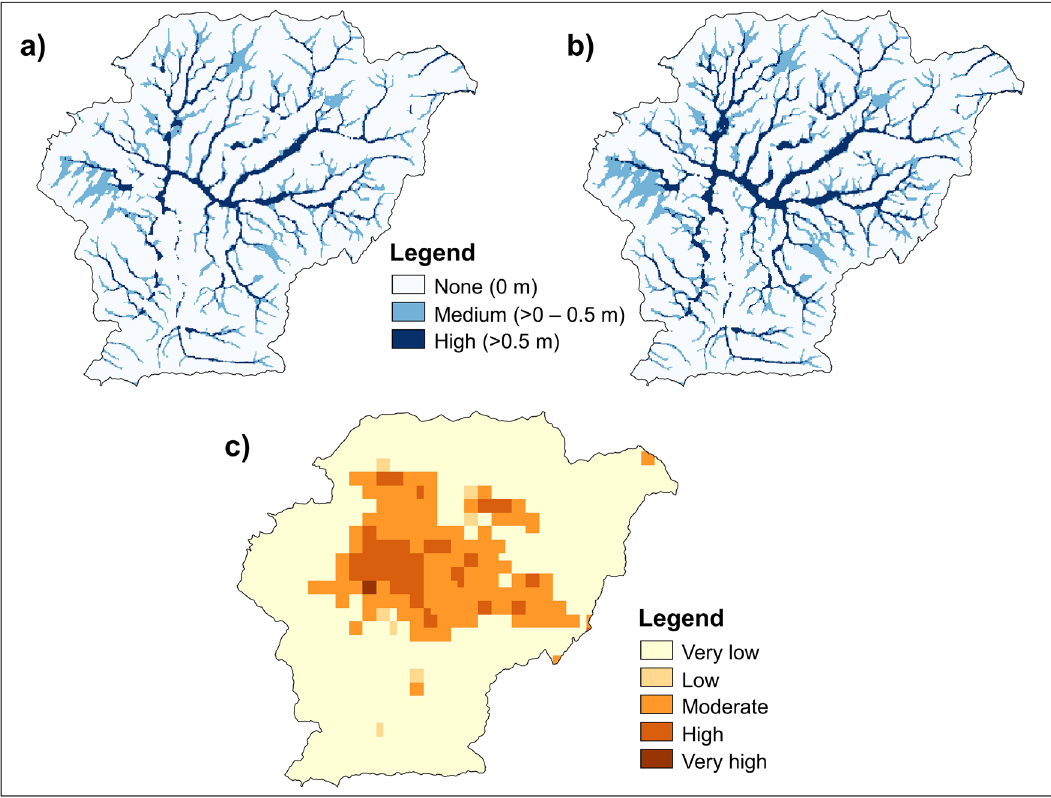
Figure 2. Characterization of considered natural hazards ( a ) Fluvial-pluvial 100-year flood hazard map; ( b ) Fluvial-pluvial 1000-year flood map; ( c ) Liquefaction susceptibility